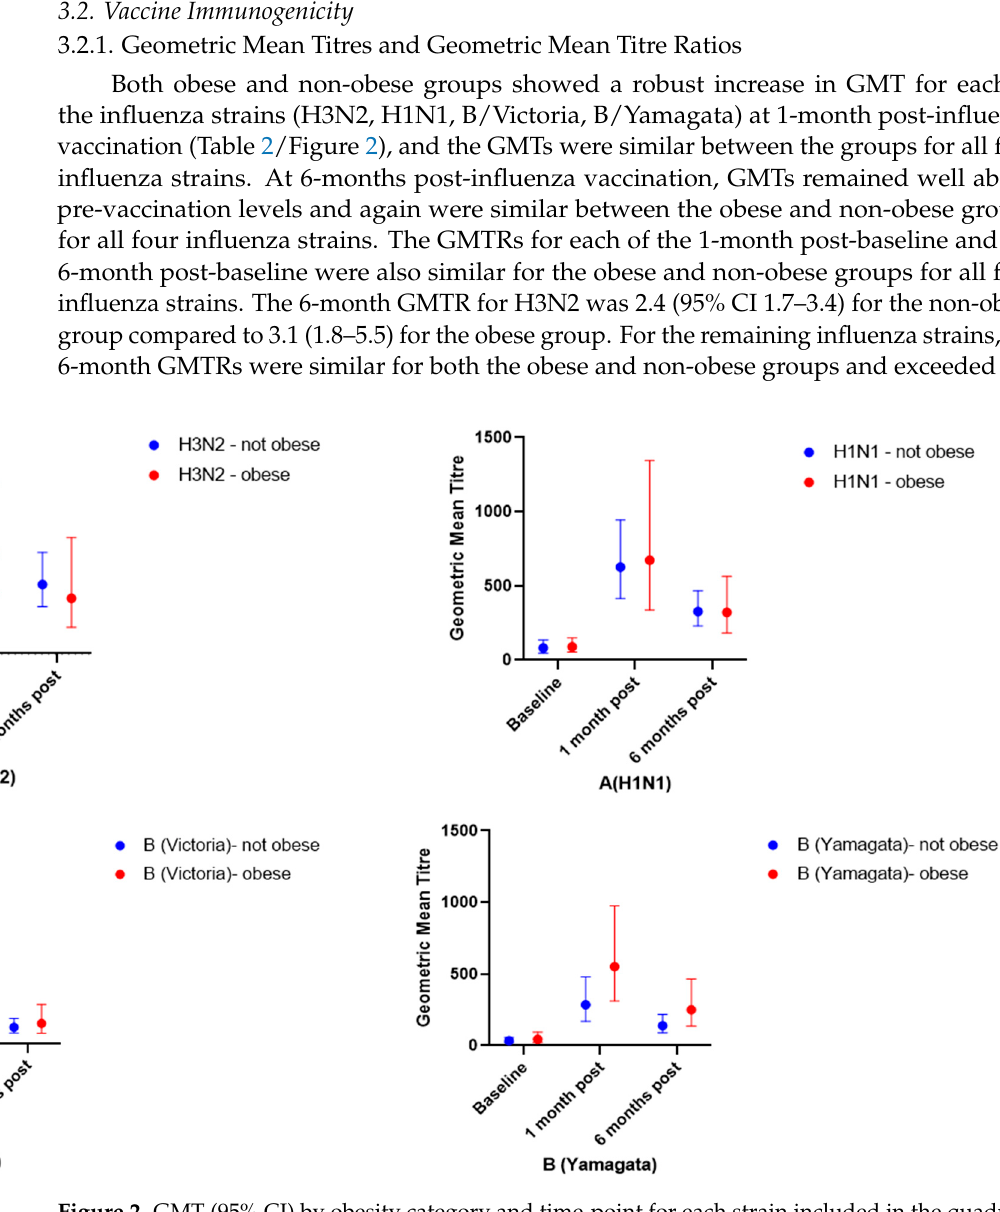
Figure 2. GMT (95% CI) by obesity category and time-point for each strain included in the quadrivalent influenza vaccine.